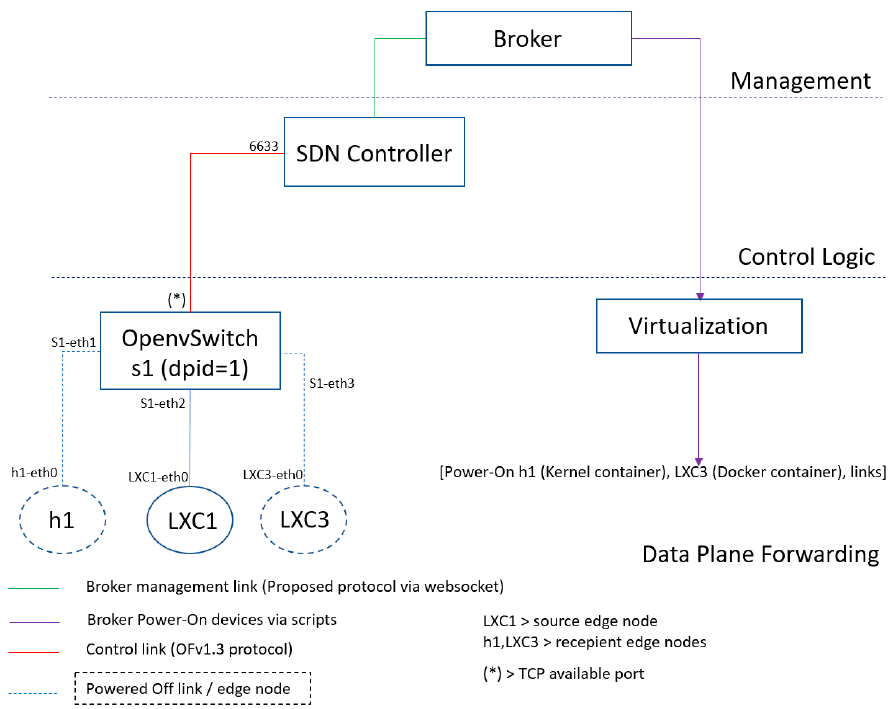
Figure 7. Initial testbed to evaluate the proposed solution. Table 2. Hardware and software tools used during the evaluation tests.